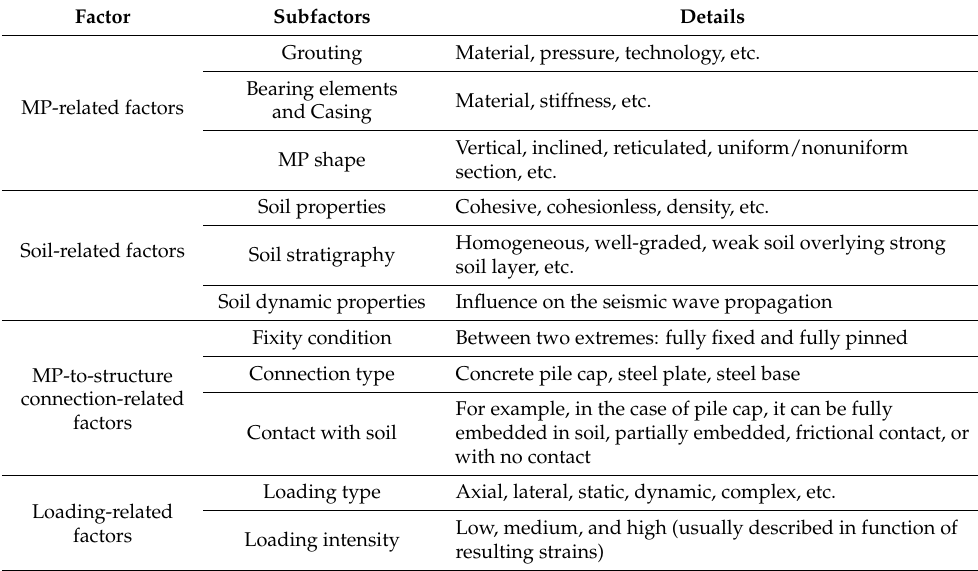
Table 2. Synthesis of factors and subfactors of influence for MP behavior (after